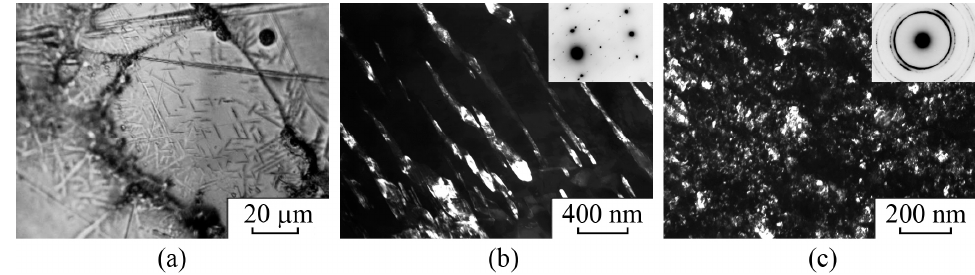
Figure 10. The structure of austenite of the steel Fe 64.7 Ni 33.6 C 1.7 . Treatment (state): ( a , b ) annealed at 873 K for 1 h (aged); ( c ) aged and HPT treated at 80 K; ( a ) optical metallography; ( b ) dark-field image taken in the combined reflection (211) (FeNi)3C ; ( c ) dark-field image taken in the combined carbide–austenitic reflection (111) γ